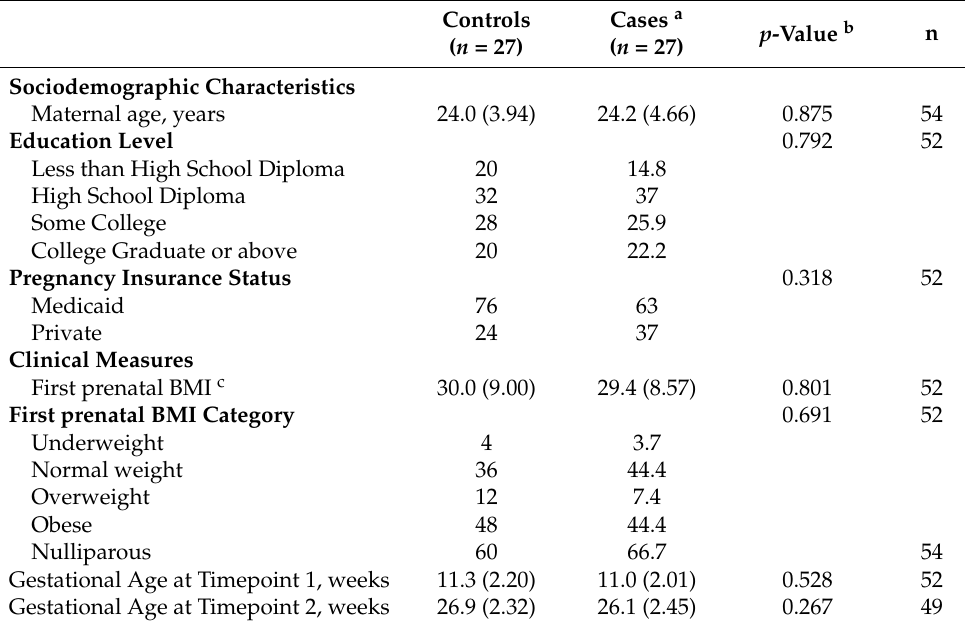
Table 1. Characteristics of Study